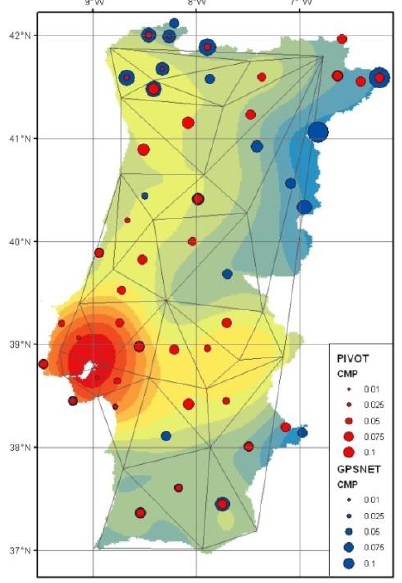
Figure 9. Spatial analysis of CMP-GPSNet™ and CTP- Trimble® PIVOT™ accuracy